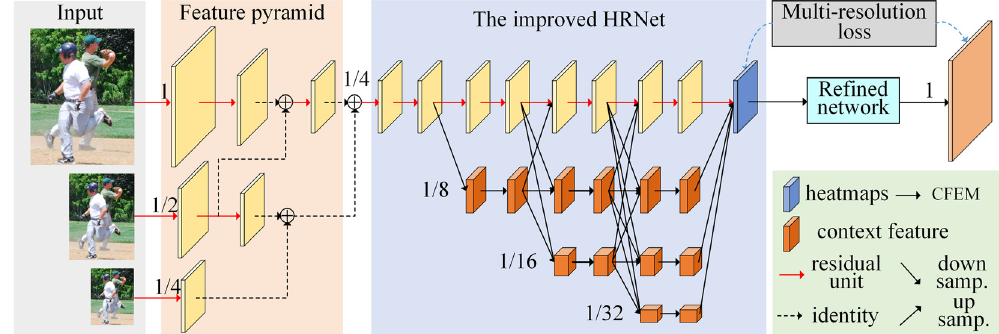
Figure 5: The overall architecture of